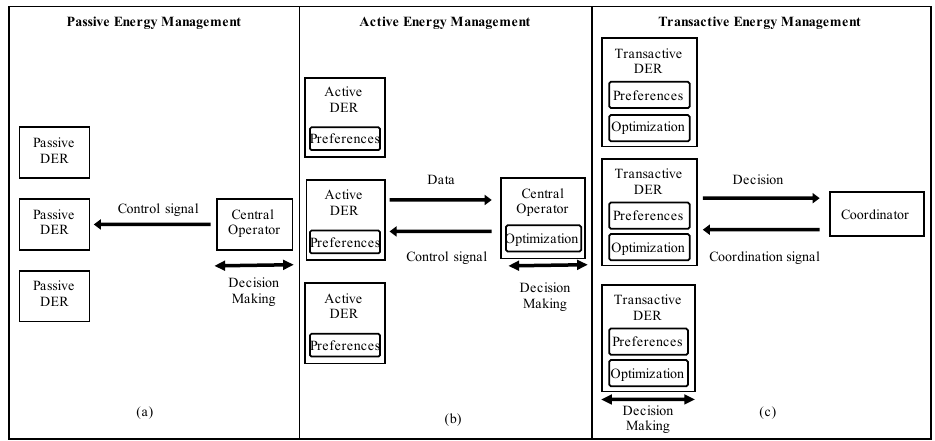
Figure 2. Different approaches for energy management: ( a ) passive management ( b ) active management ( c ) transactive